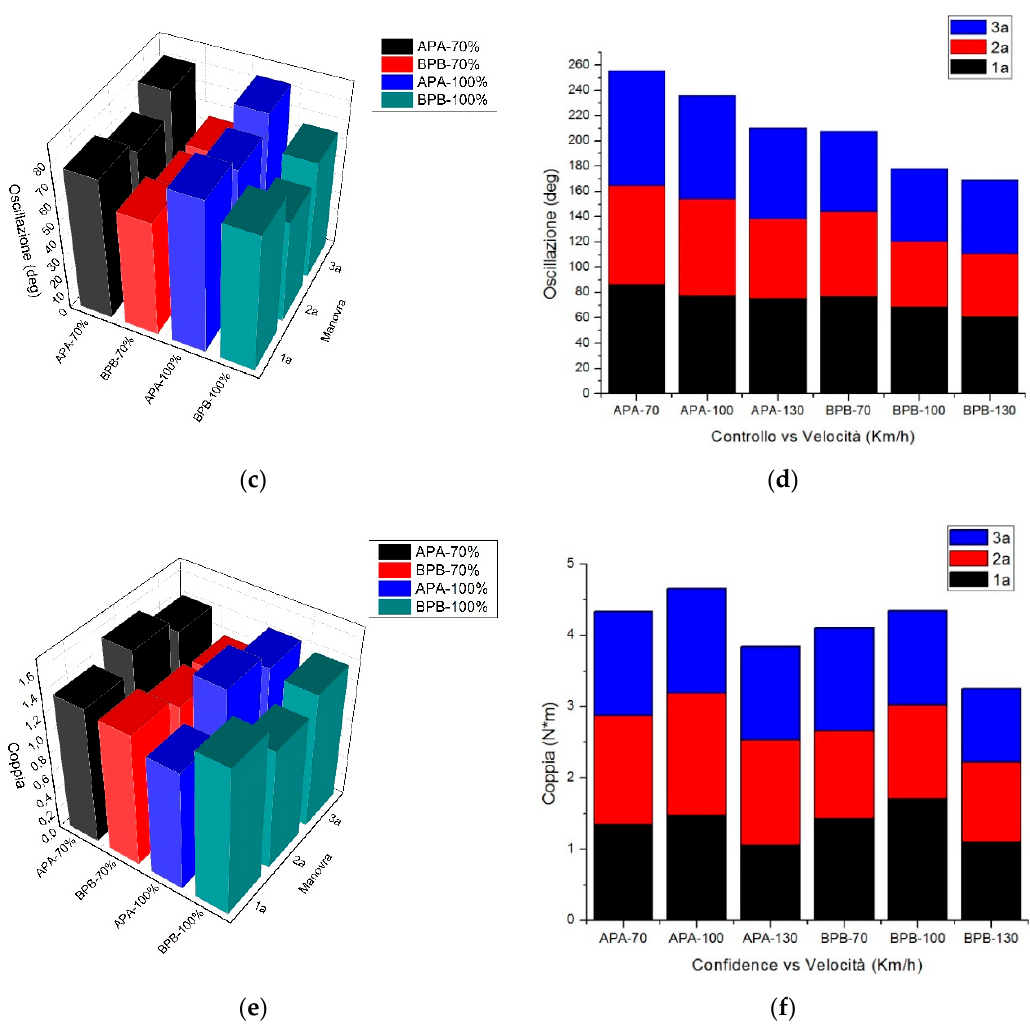
Figure A1. “Confidence” subgroups distinguished according to high or low control.